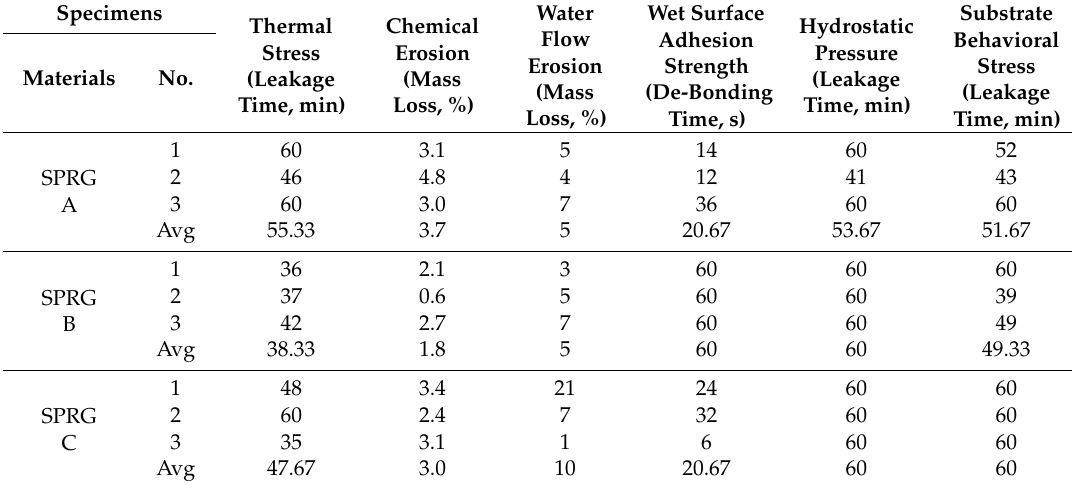
Table 9. The evaluation results of SPRG grout-injection